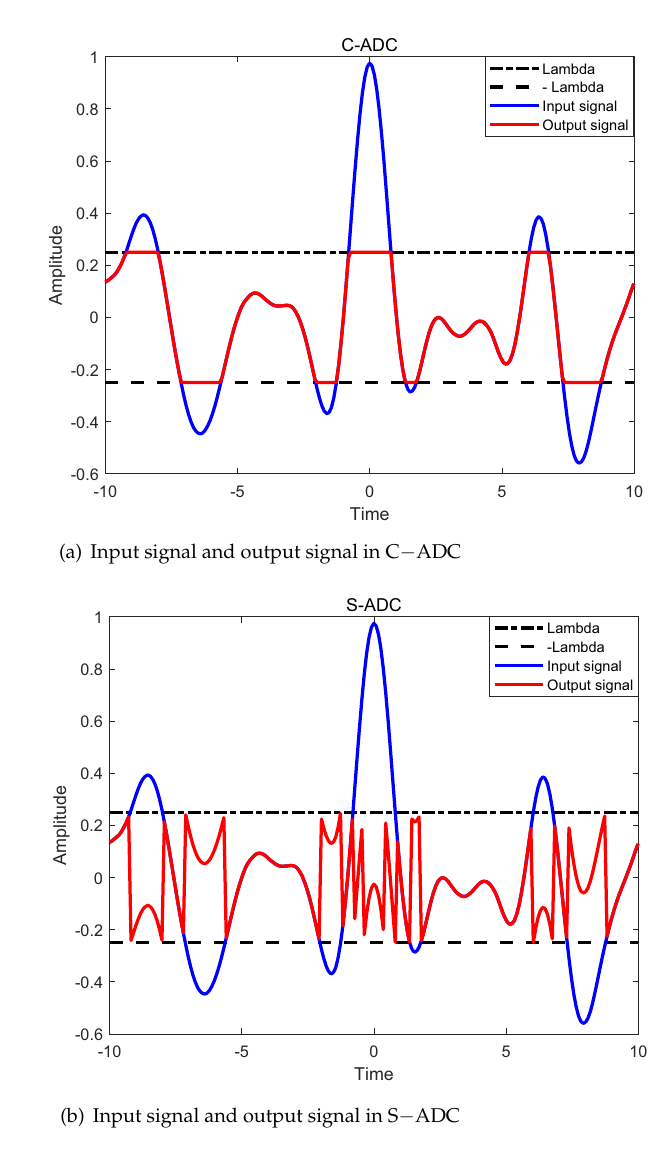
Figure 2. Conceptual difference between the C − ADC and S − ADC. ( a ) Input signal and output signal in C − ADC; ( b ) input signal and output signal in S −